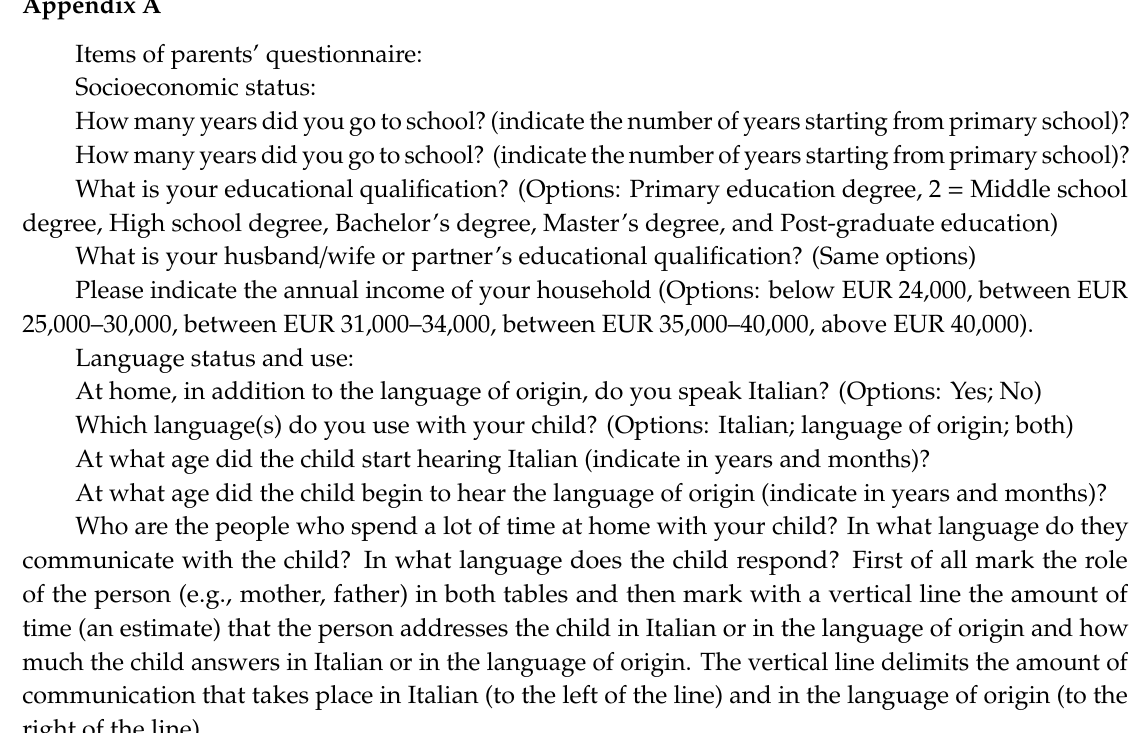
Table A1. Language experience with di ff erent people (indicate your role). How much does the person speak to the child in which language? Italian How much does the child answer in which